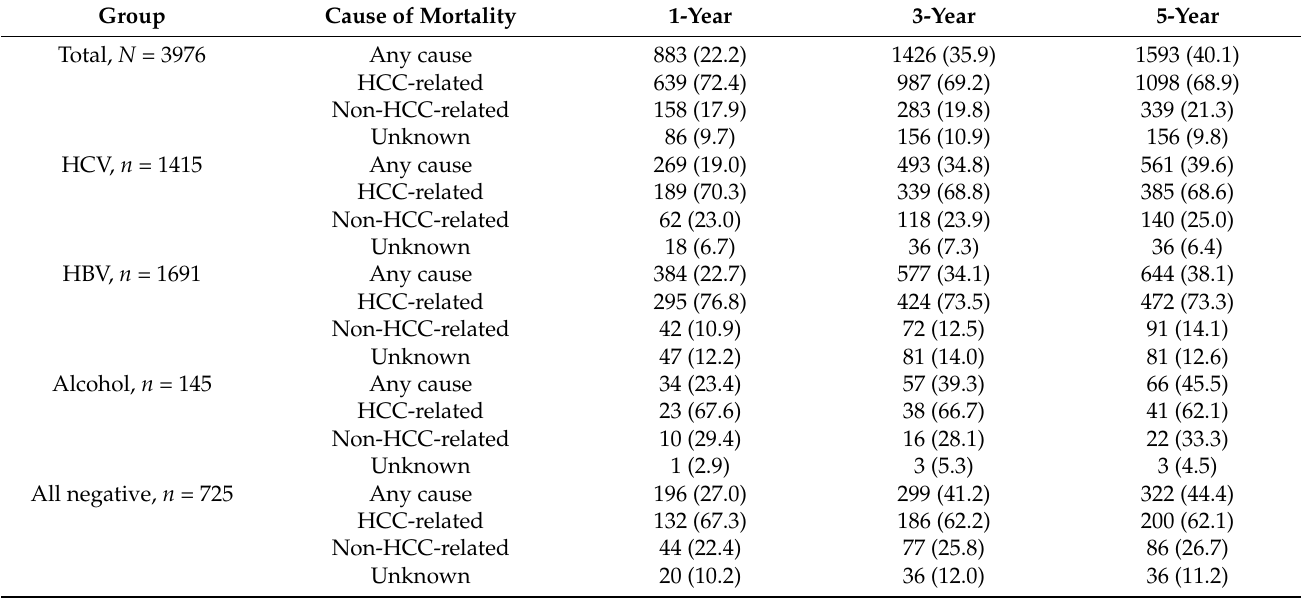
Table 2. Cause-specific mortality among all patients.